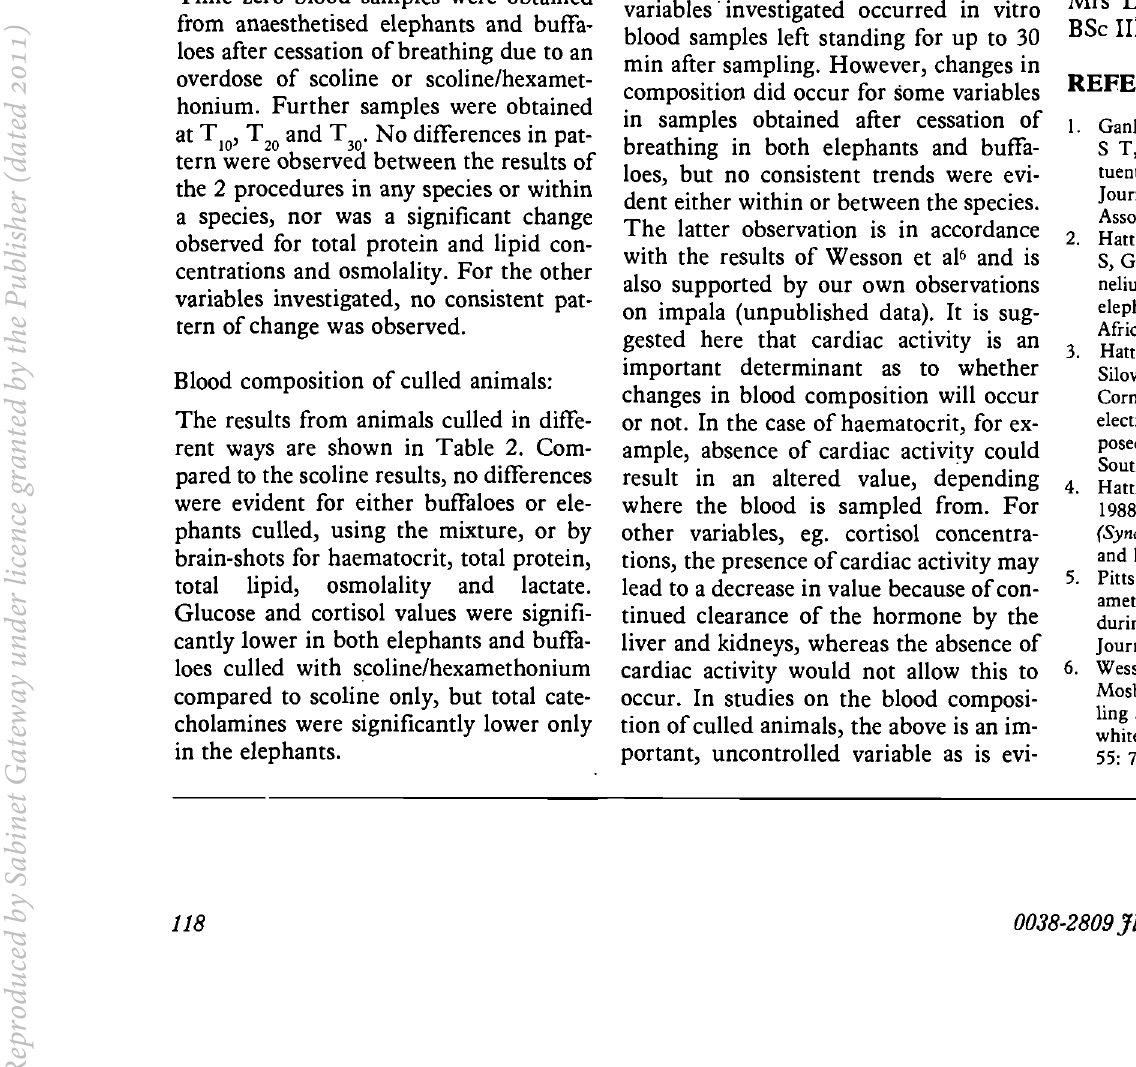
Table 2: Blood composition of elephants (E) and buffaloes (B) culled in different ways ("'indicates significantly dif ferent to the Scoline results) Variable Procedure Shot